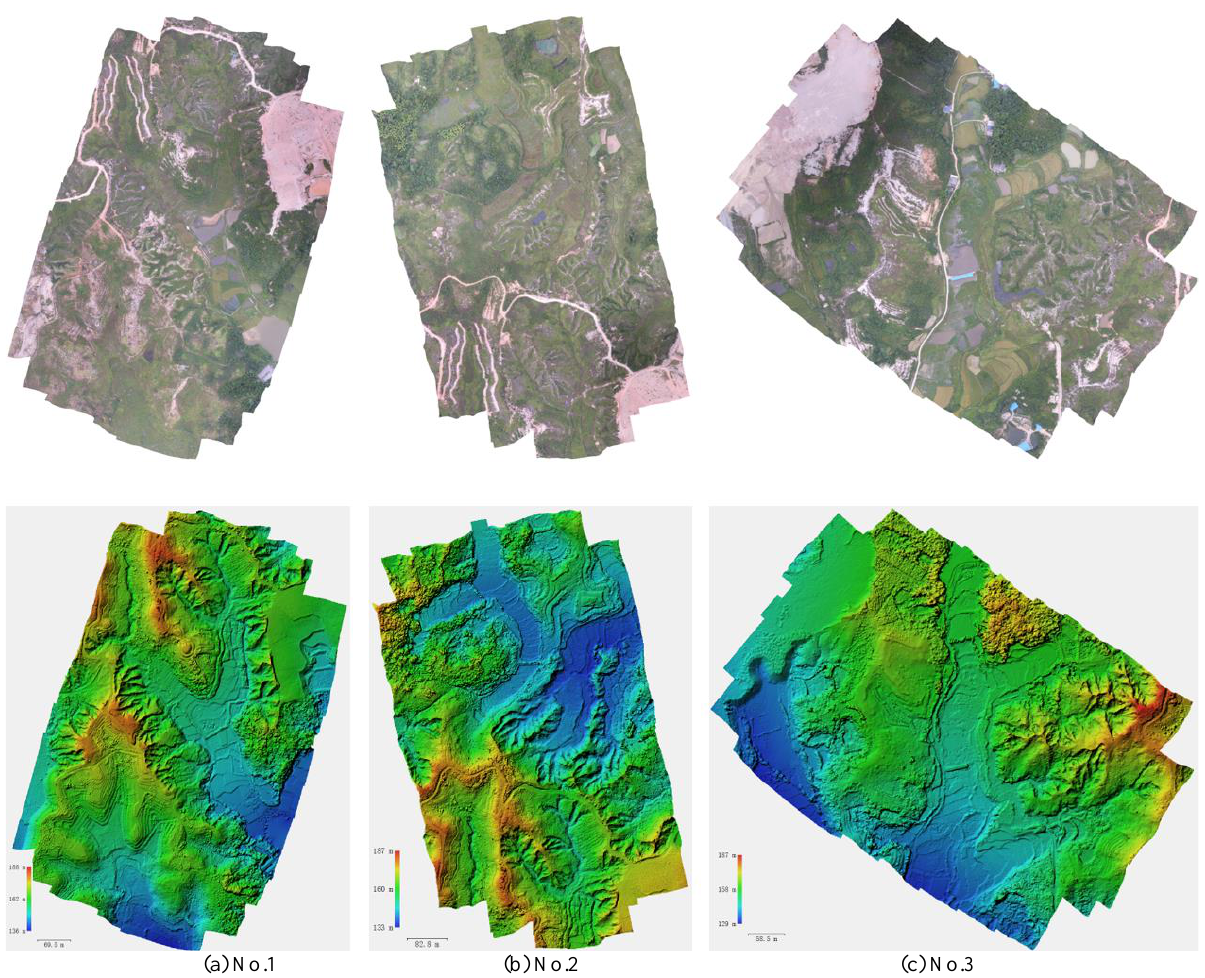
Figure 5. DOM and DSM of three Benggang